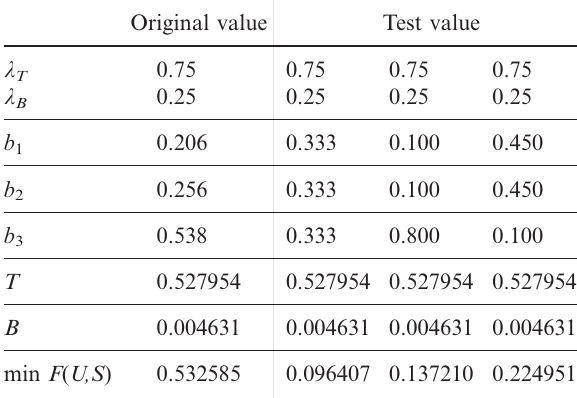
Table 7. Sensitivity analysis